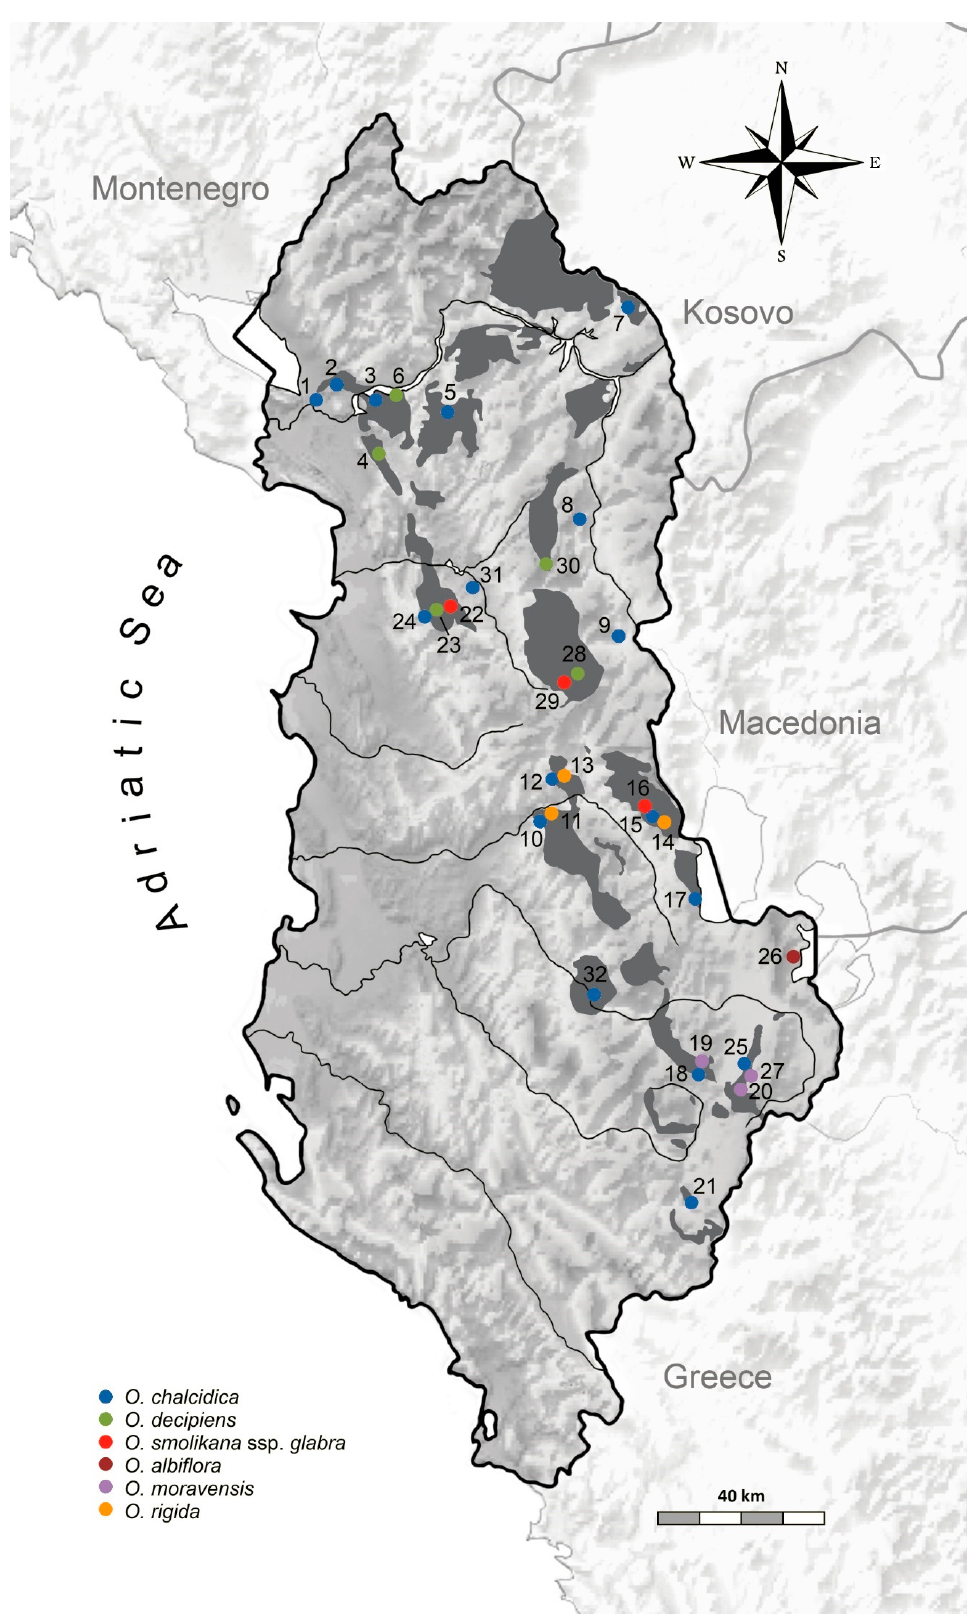
Figure 8. Location of the 32 sampled populations of Odontarrhena with species identity (colors) and distribution of the major ultramafic outcrops in Albania (dark grey